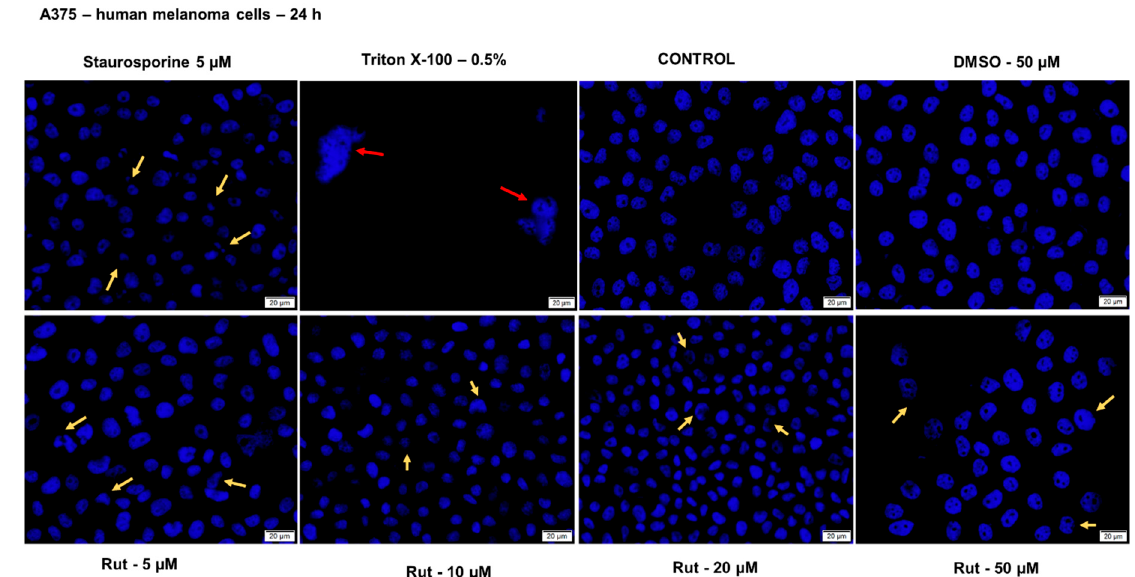
Figure 13. Cell nuclei staining using Hoechst 33342 in A375 cells after treatment with Rut (5, 10, 20 and 50 µM) and DMSO for 24 h. The pictures were taken 24 h posttreatment. Staurosporine solution (5 µM) represents the positive control for apoptotic changes at the nuclear level and Triton X-100 solution (0.5%) for necrosis. The yellow arrows indicate apoptotic cells with nuclear fragmentation, and the red arrow indicates necrotic cells. The scale bars represent 20 µm.